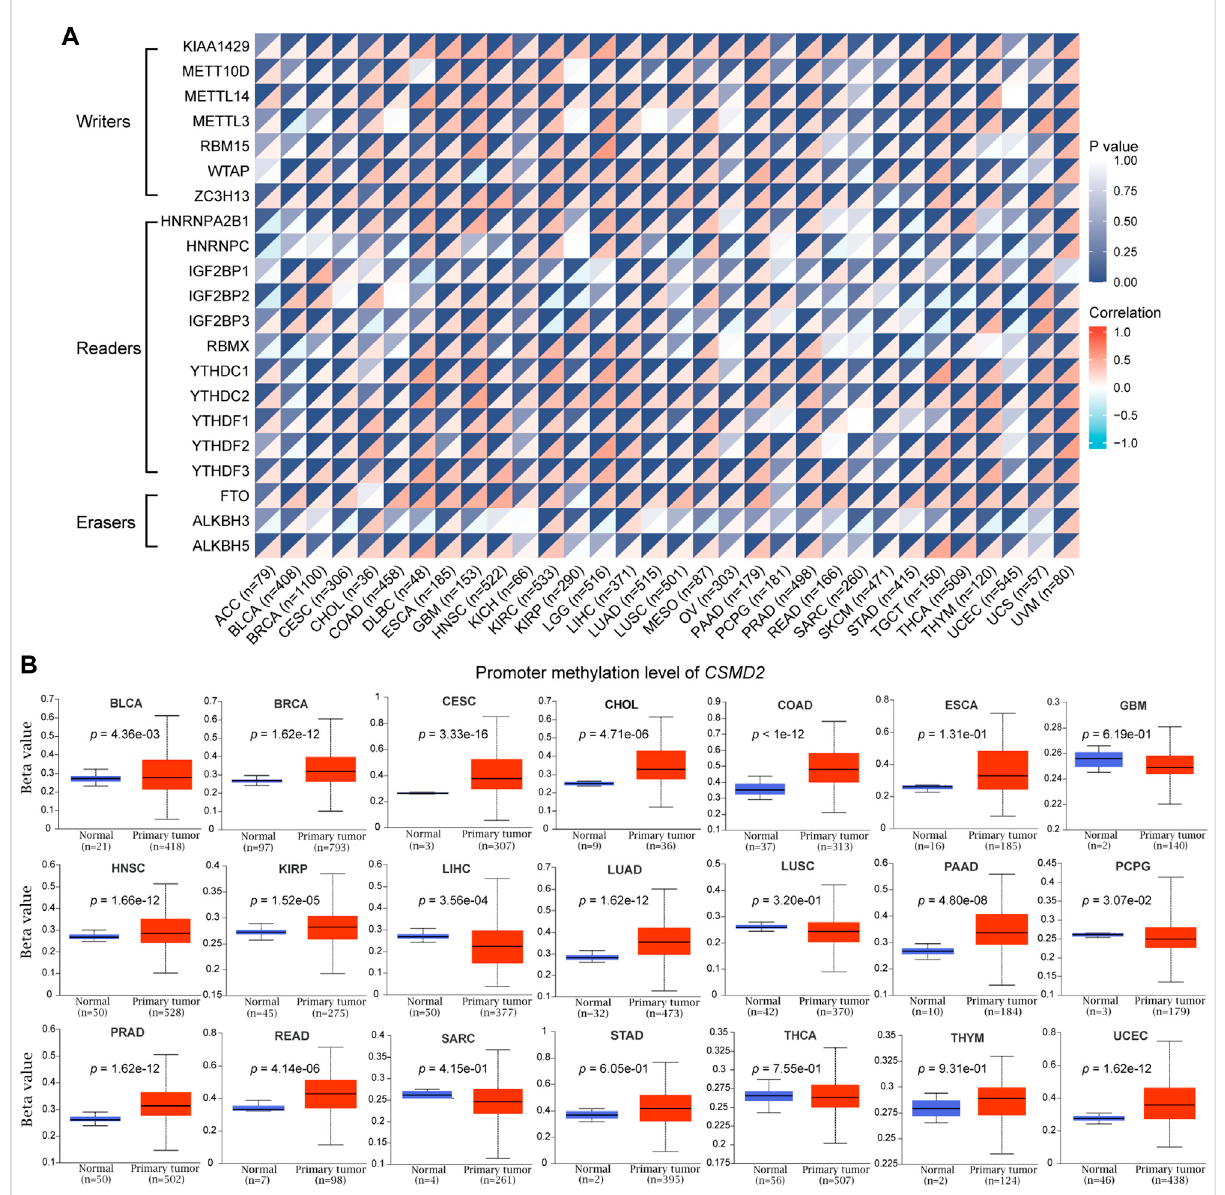
FIGURE 6 Epigenetic methylation analysis of CSMD2. (A) The correlation between the expression of CSMD2 mRNA and m6A methylation regulatory factors in multiple cancers. Correlations are depicted with Spearman ’ s rho values and statistical signi fi cance. (B) Differential promoter methylation level (beta values) of CSMD2 in normal tissues and tumors based on